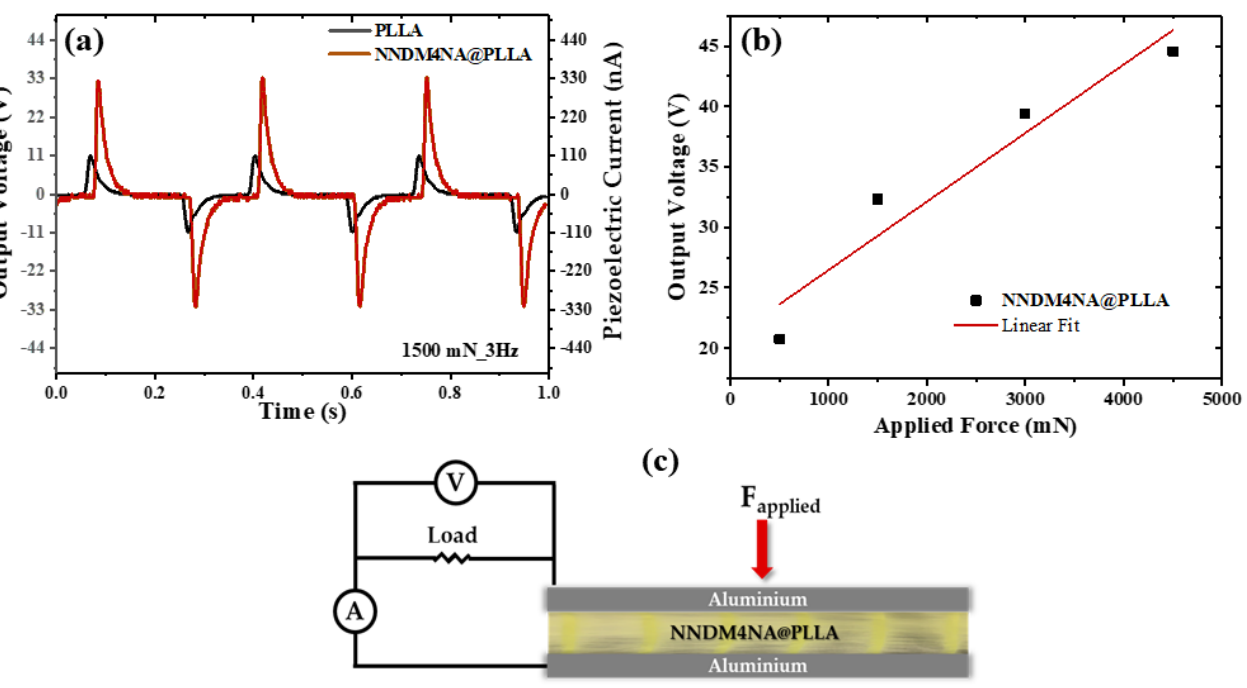
Figure 6. ( a , b ) Output voltage (V) and current (nA) measured through a load resistance of 100 MΩ on the electrospun fiber array of PLLA and PLLA doped with NNDM4NA nanocrystals, ( c ) and schematic piezoelectric setup for the NNDM4NA@PLLA fiber array. schematic piezoelectric setup for the NNDM4NA@PLLA fiber